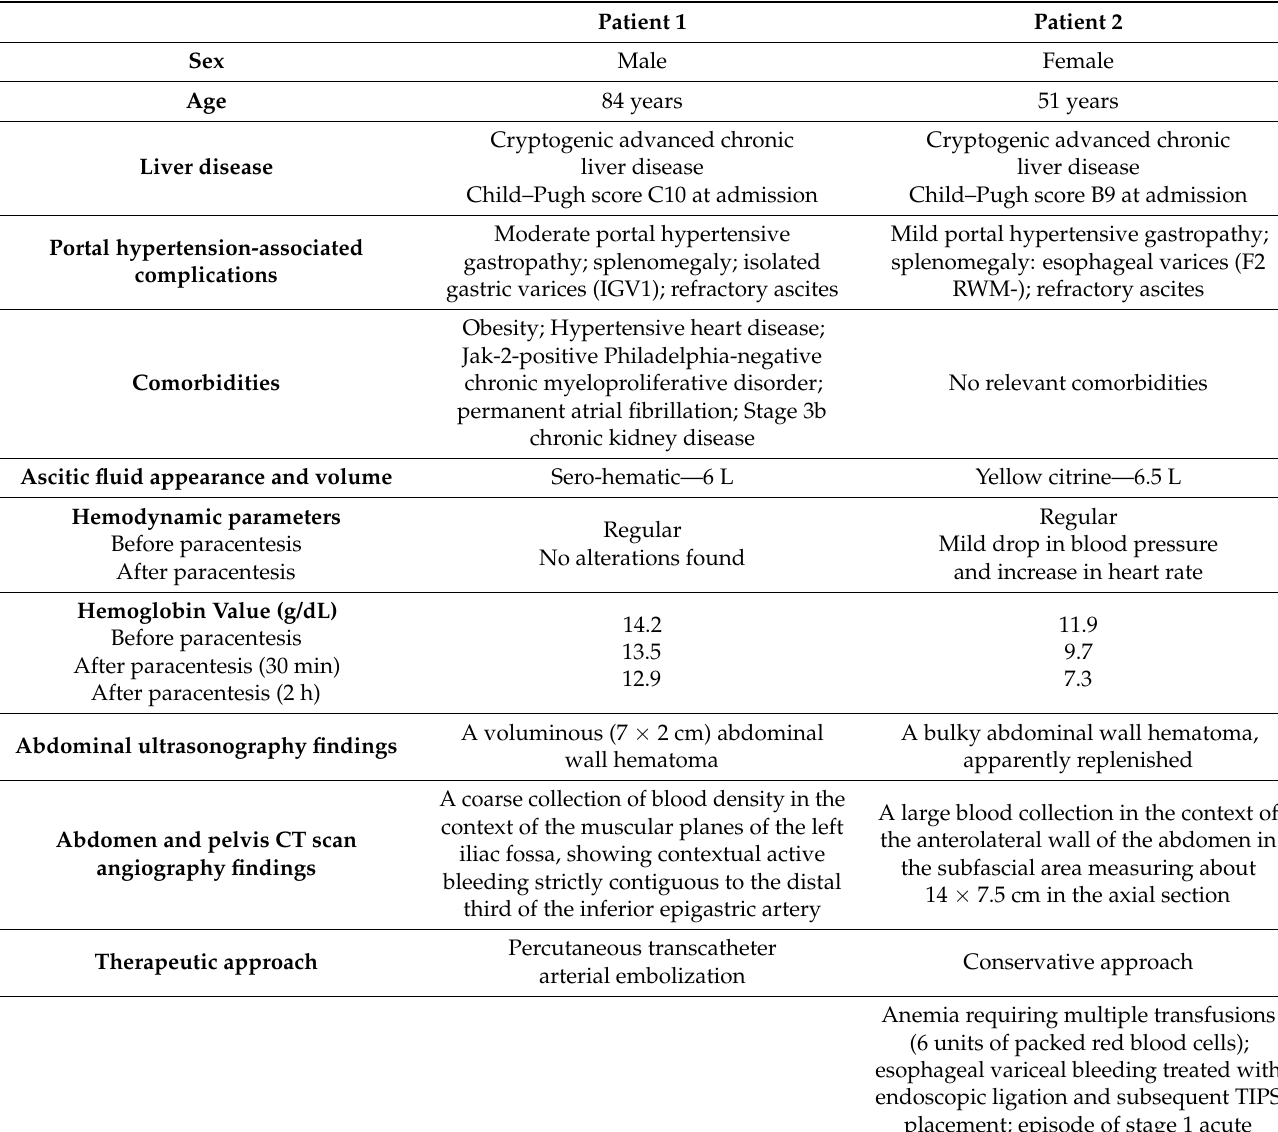
Table 1. Clinical features of the two